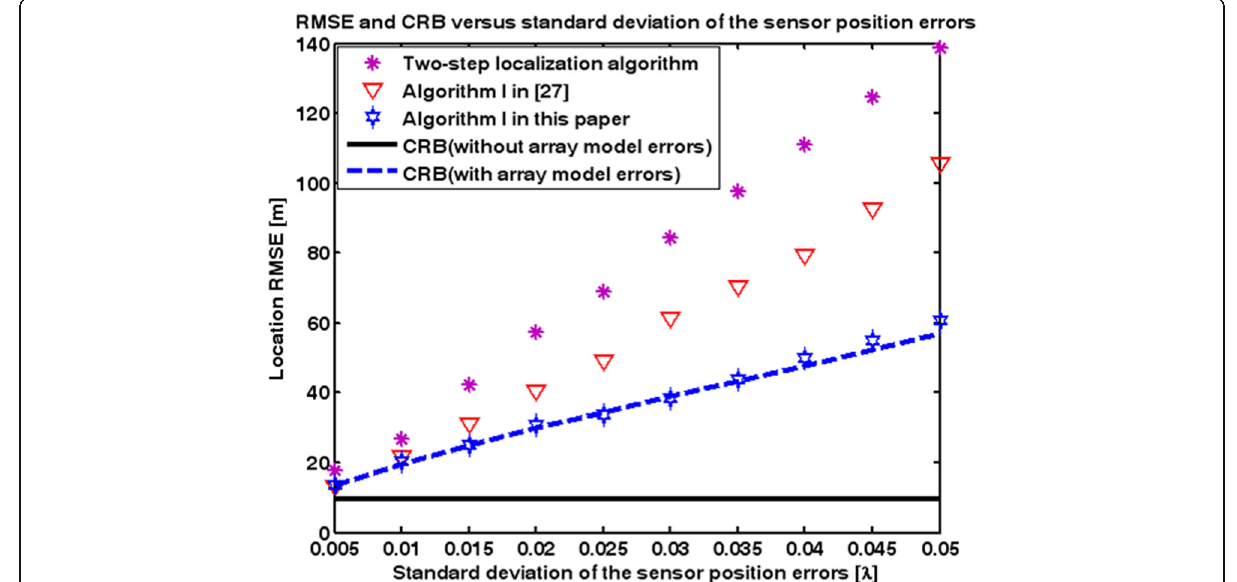
Fig. 3 RMSEs of localization methods and the corresponding CRBs as a function of standard deviation of sensor position errors for case of unknown signal